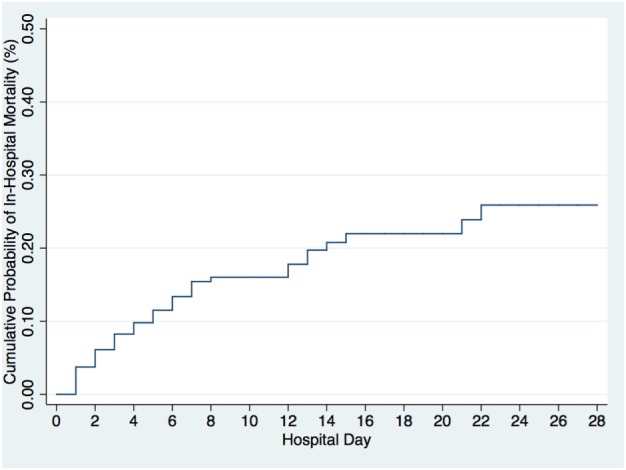
Cumulative probability of in-hospital mortality by hospital day.